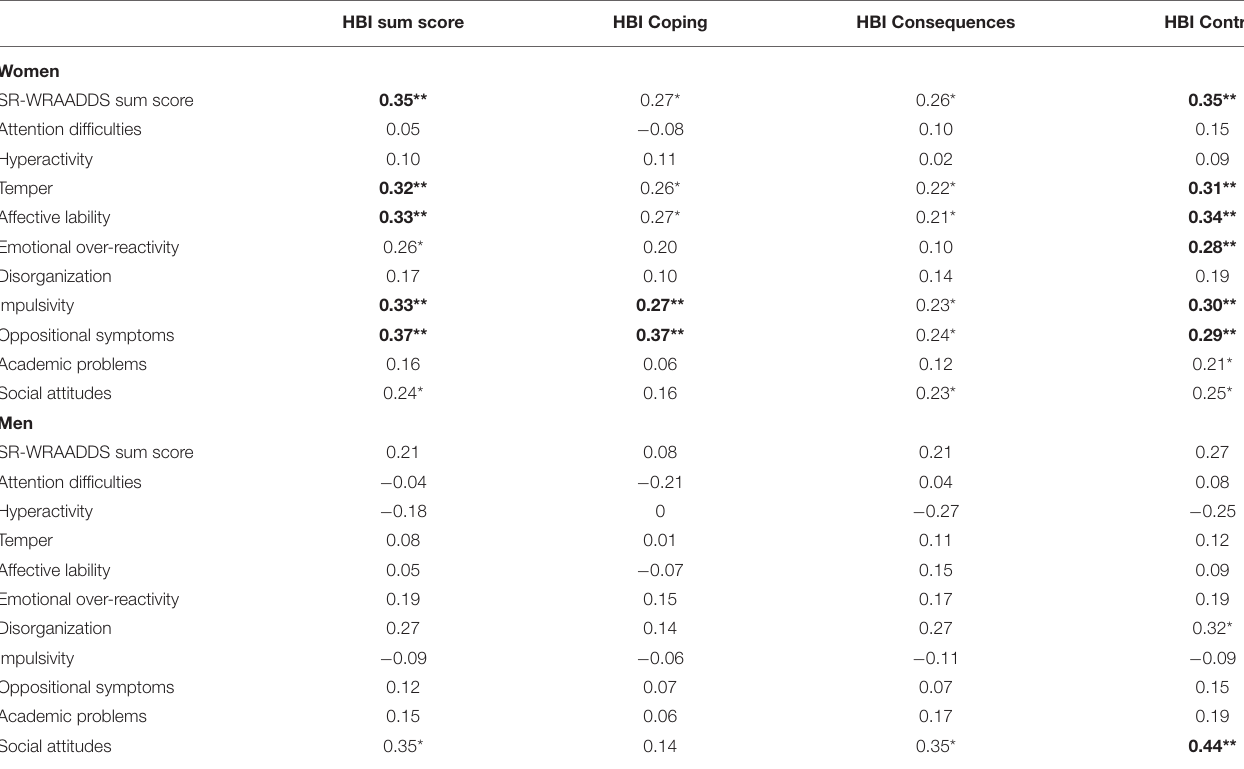
TABLE 4 | Associations between ADHD symptoms and hypersexual behaviors in women and men with ADHD using the SR-WRAADDS and the